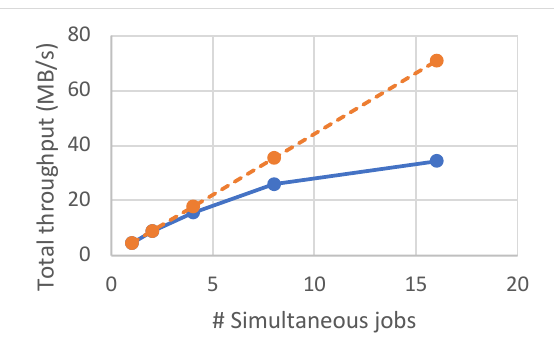
Figure 4: Throughput achieved with increasing number of simultaneous jobs (solid line), compared with perfect scaling (dashed line).